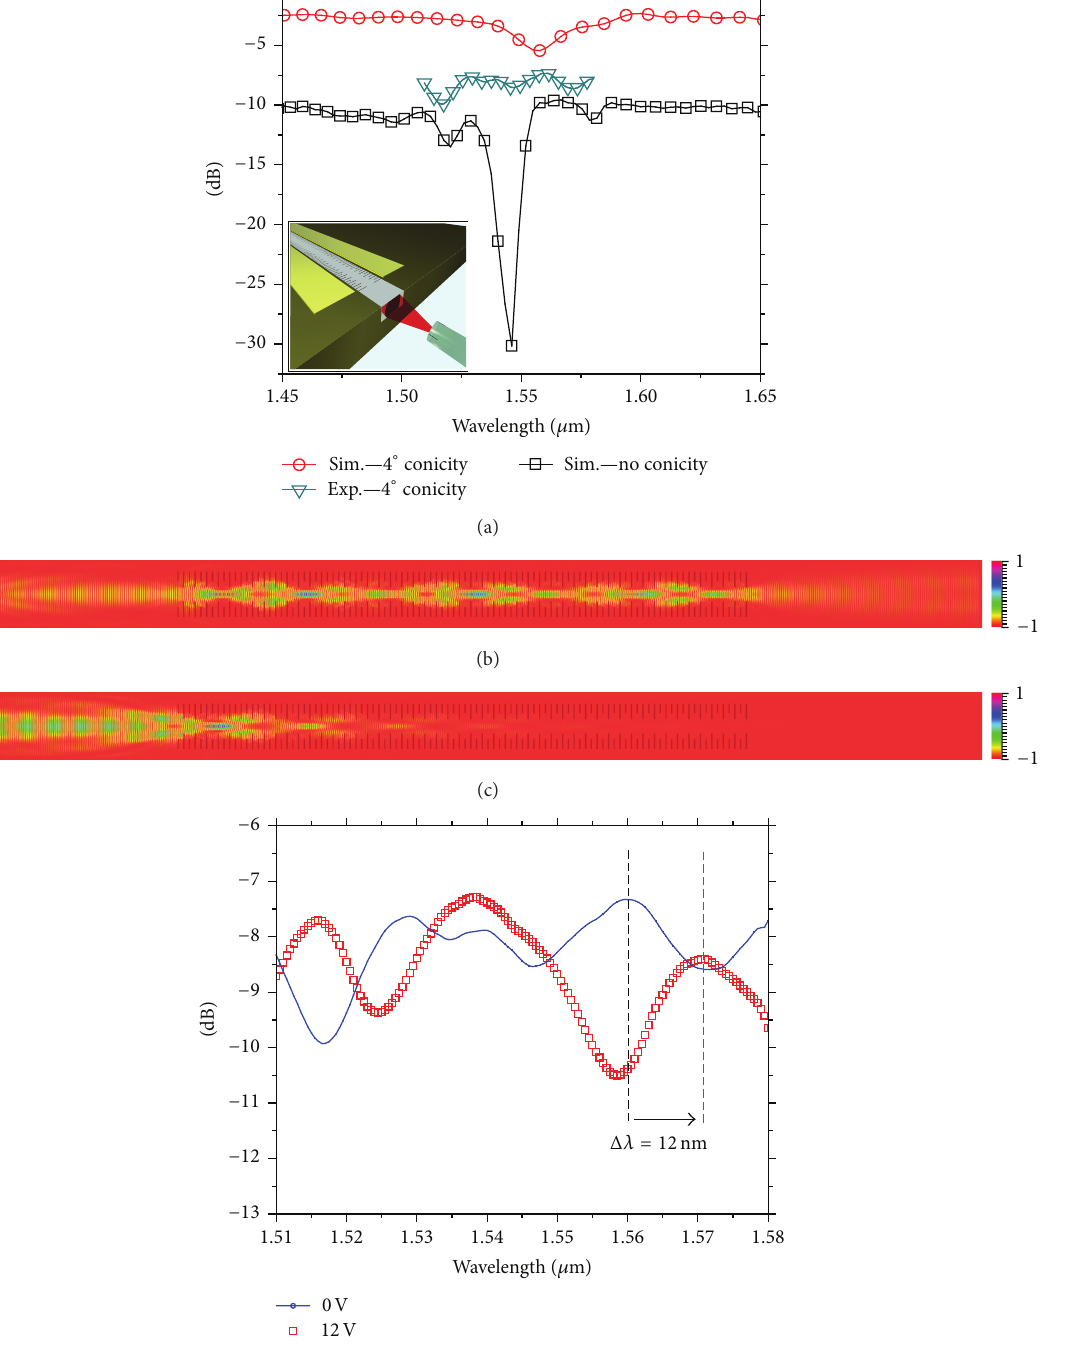
Figure 3: (a) Measured optical transmission spectrum. Simulated field transmission patterns (b) at 1.6 𝜇 m and (c) at 1.54 𝜇 m wavelengths. (d) The electrooptic shift in the optical transmission